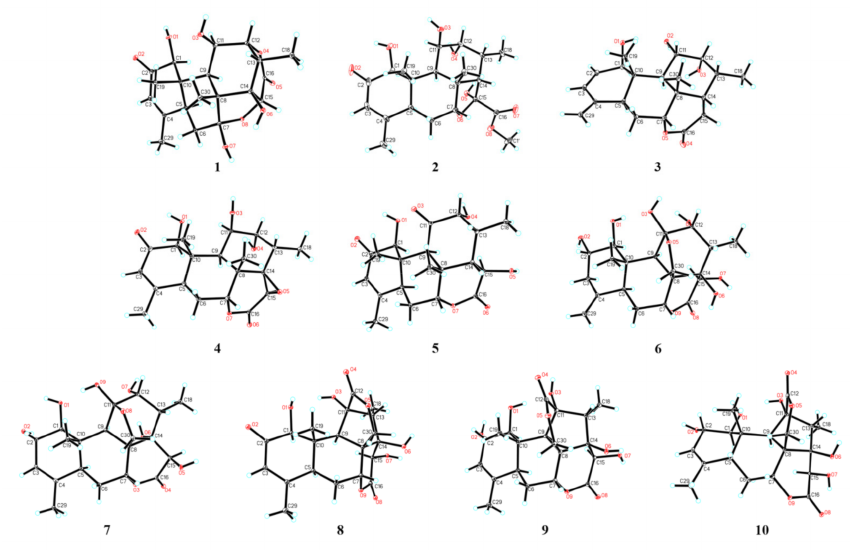
Figure 4. X-ray ORTEP drawings of compounds 1 – 10